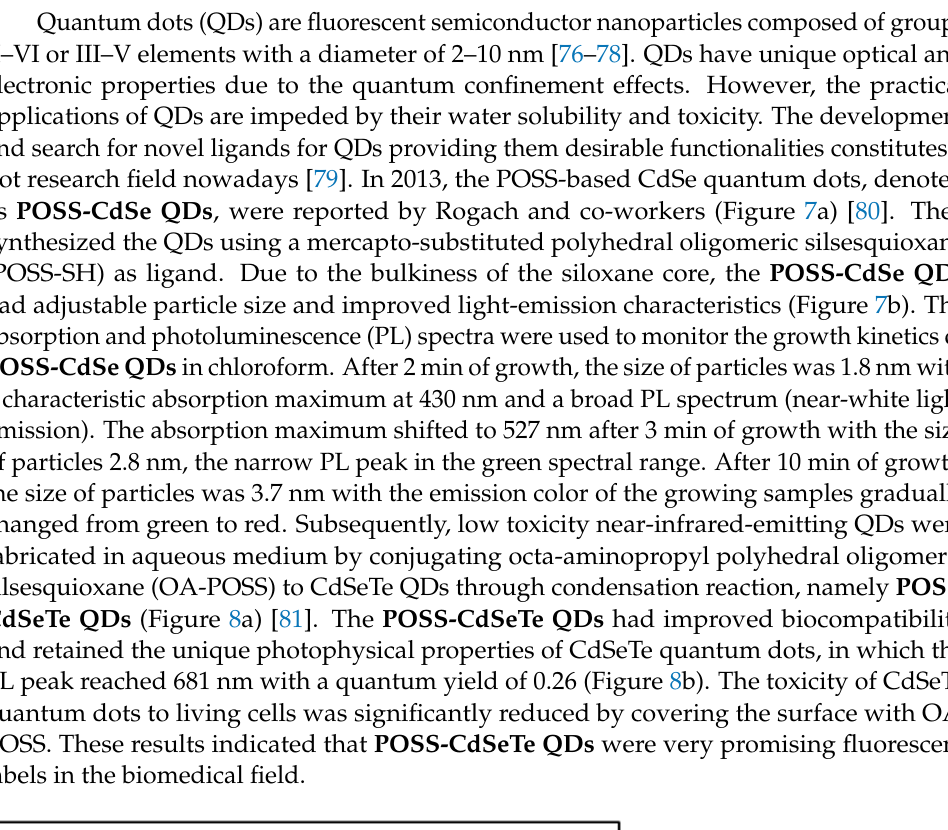
Figure 6. Synthetic procedure of PProDOT-POSS [75].